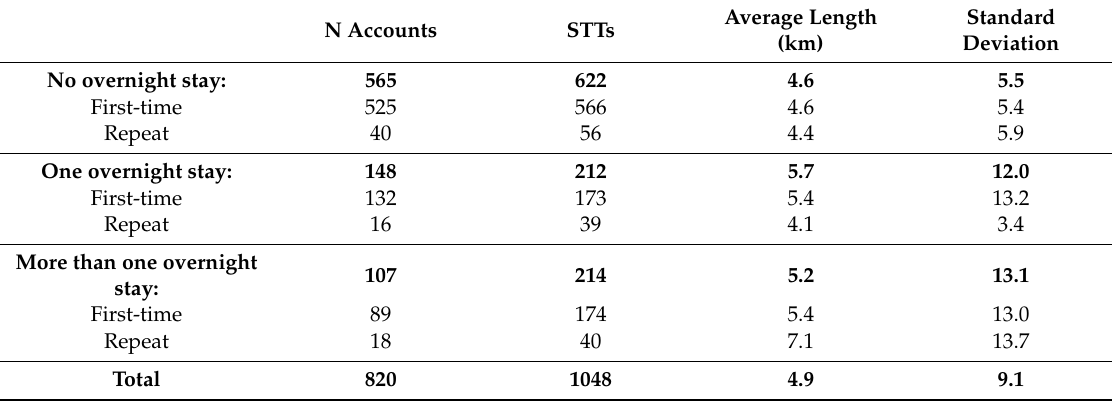
Table 4. Descriptive statistics of the visitor spatiotemporal trajectories (STTs) that were reconstructed. Average N Accounts STTs